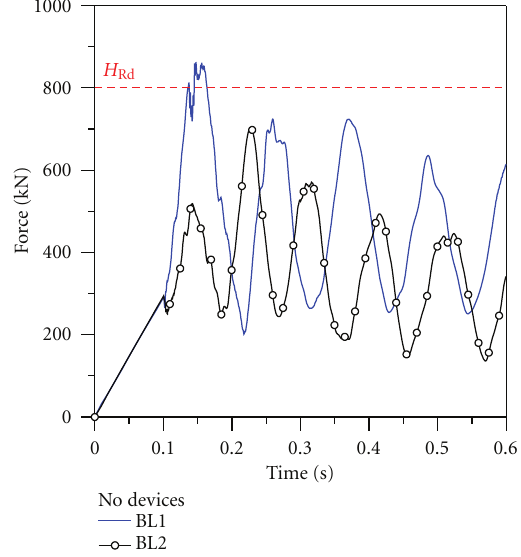
Figure 10: Comparison of axial force in the cables, as a function of time (ABAQUS). No devices. M01 FE-model, BL1 and BL2.